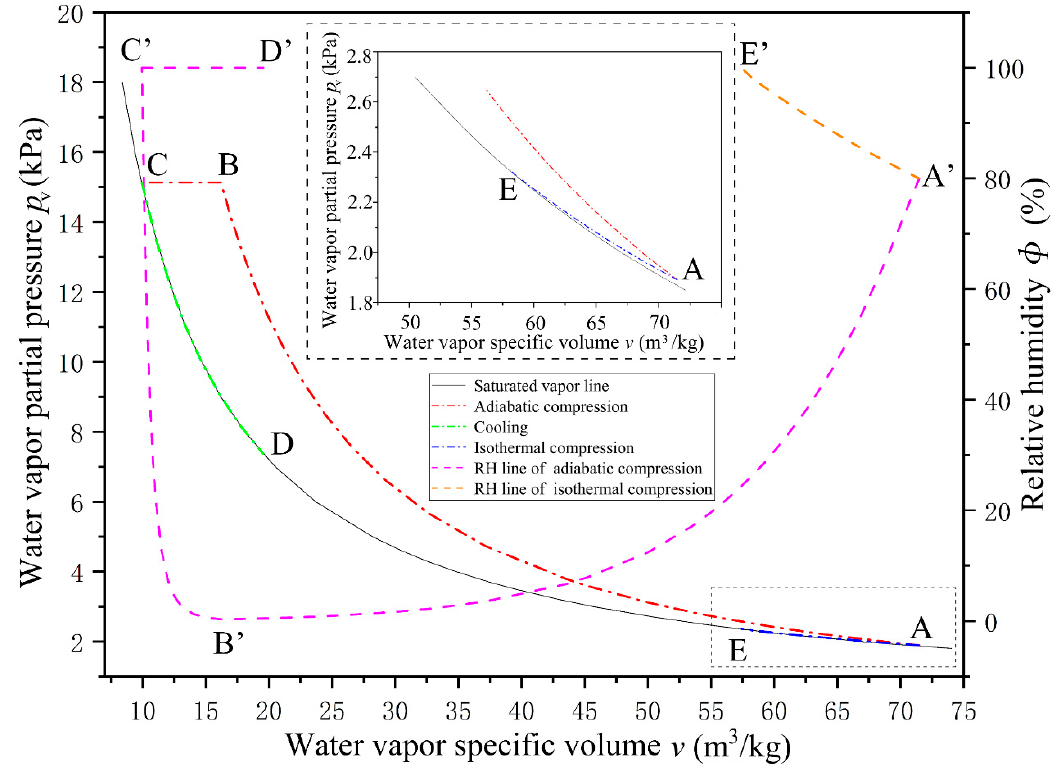
Figure 5. The thermophysical process of water vapor in moist air.